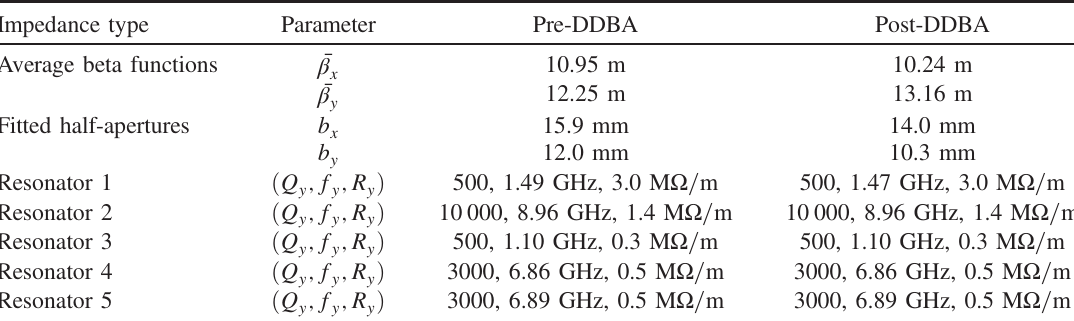
TABLE III. Comparison of impedance model parameters before and after the installation of the DDBA cell used for multi-bunch instability studies.